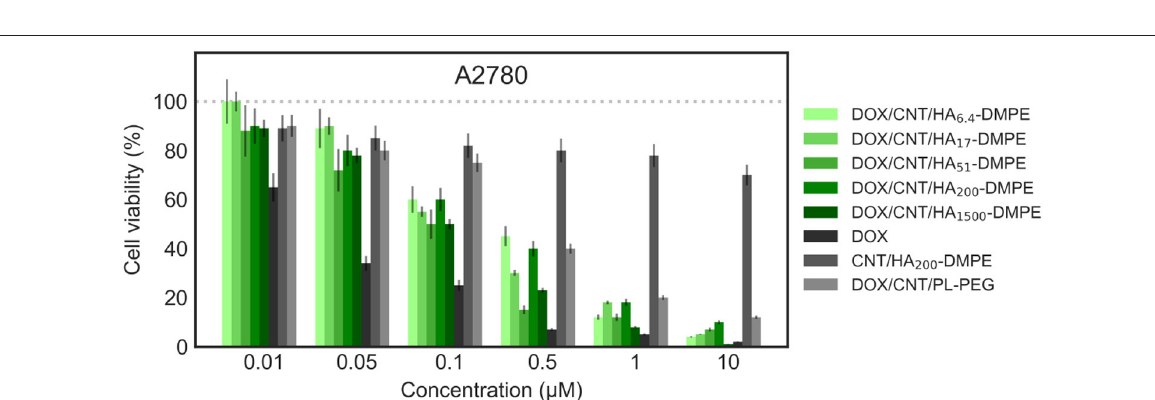
time (higher for A2780 with 1 log decrease from 24 to 48